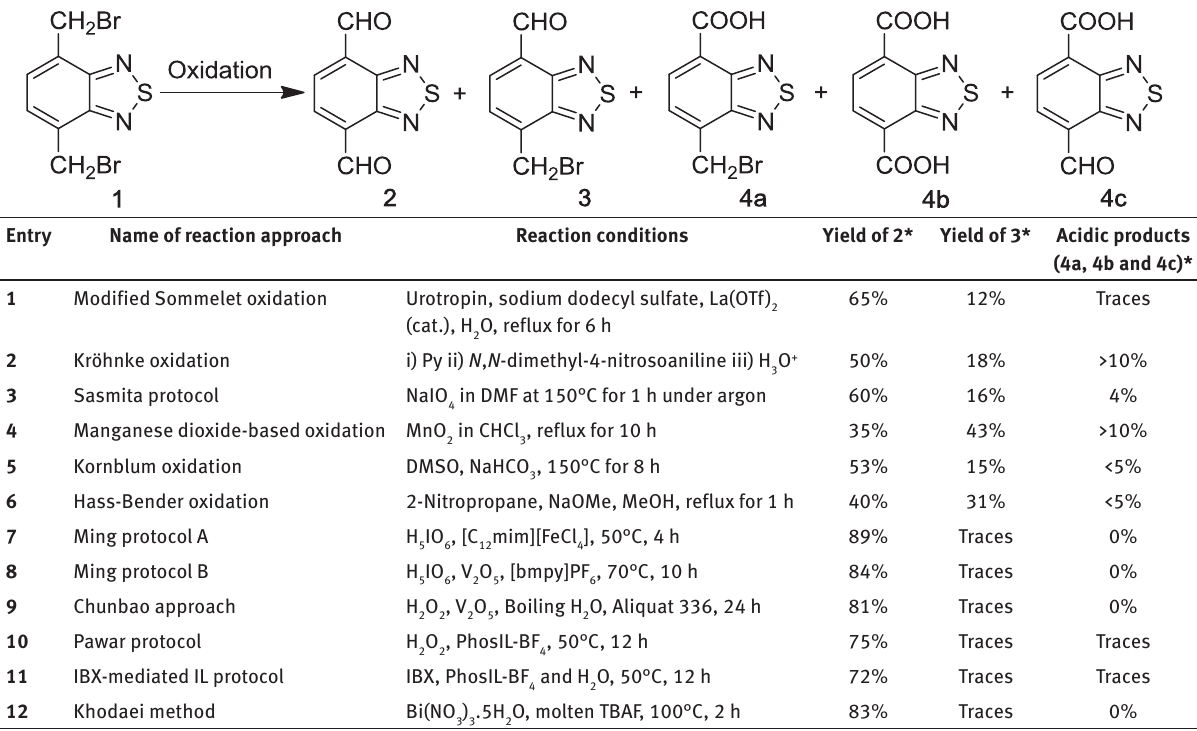
Entry Name of reaction